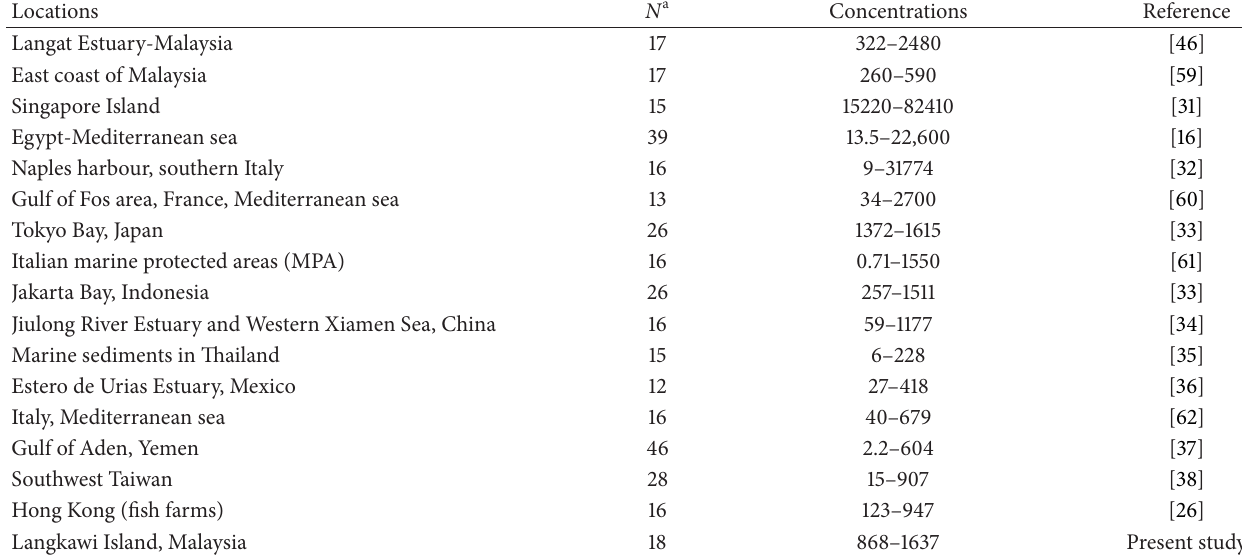
Table 5: PAH concentrations (ngg − 1 d.w.) in sediments from various marine sites in the world. Locations N